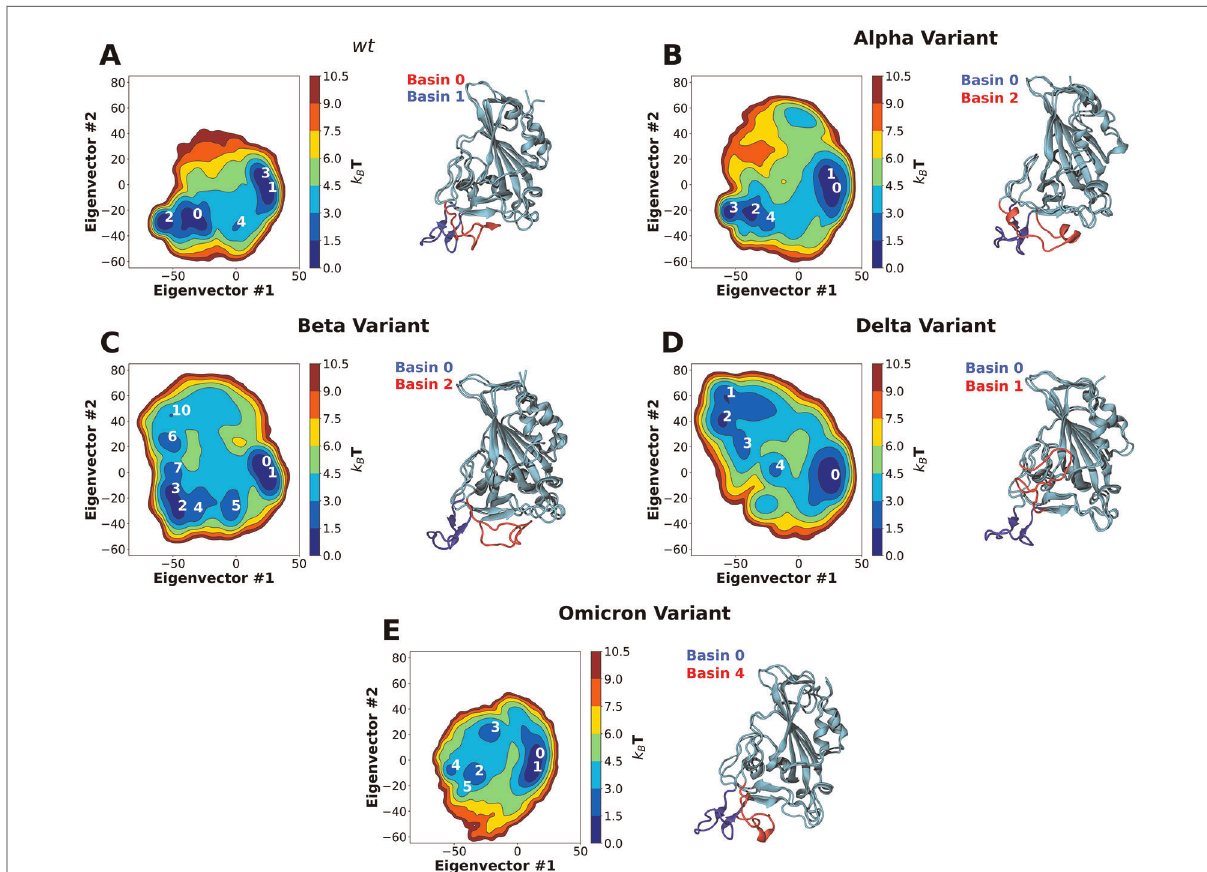
FIGURE 2 Two-dimension principal component analysis (PCA) of SARS-CoV-2 RBD conformational dynamics in water. Plots of the fi rst two principal components determined from the C α backbone of the wt RBD ( A ) as well as the Alpha ( B ), Beta ( C ), Delta ( D ) and Omicron ( E ) variants. Basins with k B T<3 are numbered in each fi gure. Snapshots of the lowest energy structures for selected open and closed basins are also shown. The ridge regions of the open and closed snapshots are colored in blue and red,